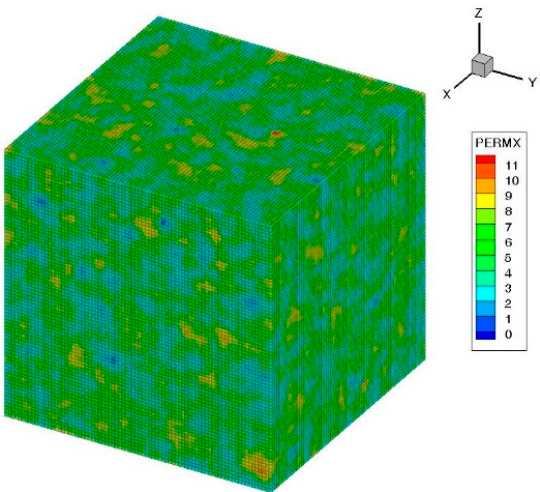
Figure 4. The log permeability field with a relatively large cell size generated by GenPack.